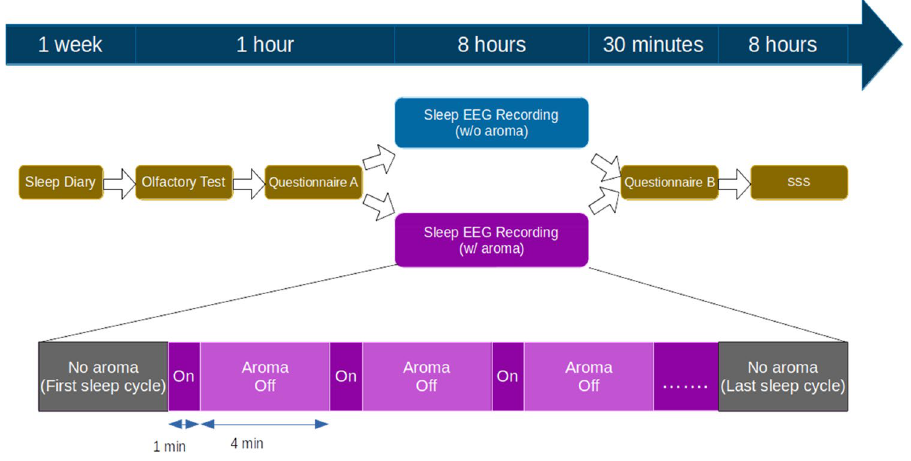
Figure 1. Experimental